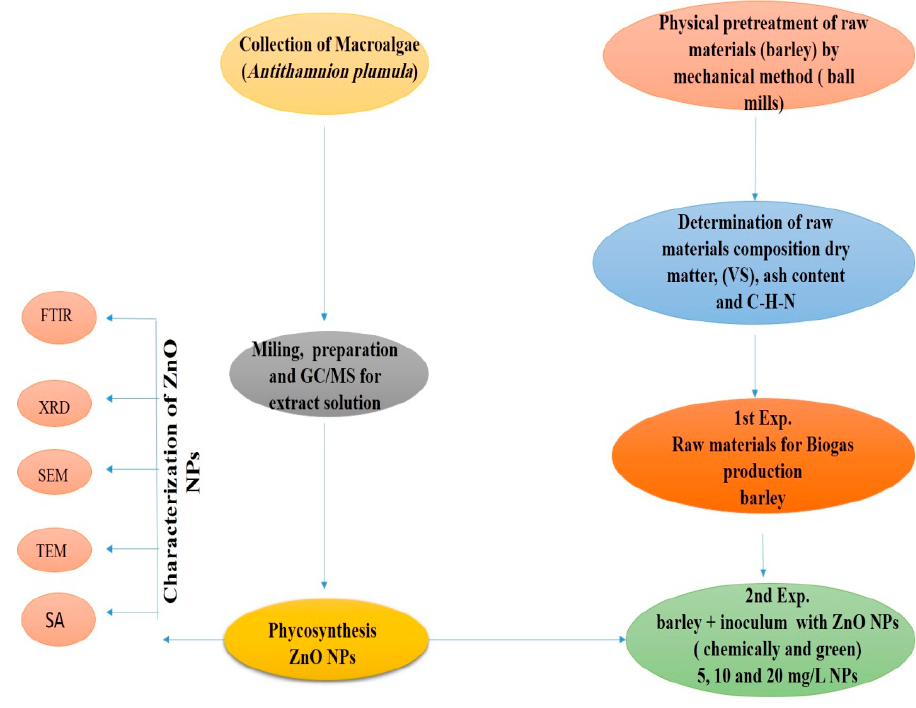
Figure 1. Flow chart of the experimental procedures.